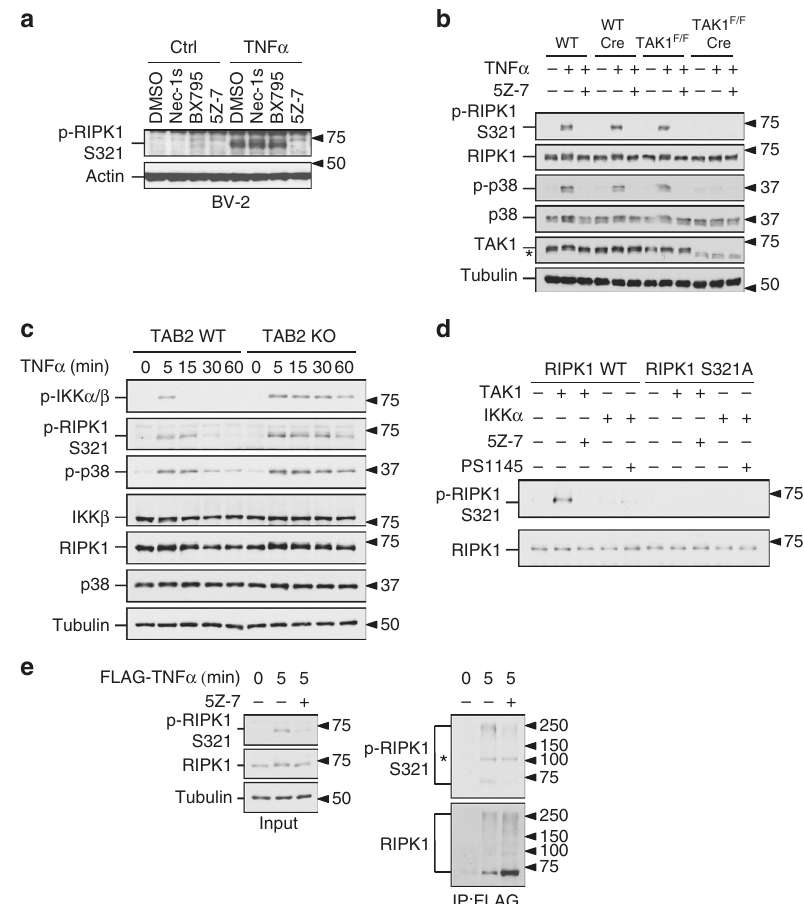
Fig. 2 TAK1 phosphorylates RIPK1 at S321. a TNF α -induced RIPK1 S321 phosphorylation is inhibited by TAK1 inhibitor. BV-2 cells were treated by TNF α (20 ng/ml) together with DMSO, Nec-1s (10 µ M), TBK1 inhibitor, BX795 (1 µ M) and 5Z-7 (0.5 µ M). b TAK1 is required for RIPK1 S321 phosphorylation. WT and TAK1 F/F MEFs with or without Cre expression were treated with TNF α (10 ng/ml) and 5Z-7 (0.5 µ M) for 15 min and examined by indicated antibodies. c Hyperphosphorylation of RIPK1 S321 in TAB2 KO MEF. TAB2 WT and KO MEFs were treated with TNF α (10 ng/ml) and the samples were collected at indicated time-points. d FLAG-RIPK1 WT and S321A were expressed and puri fi ed from 293T cells and incubated with recombinant TAK1-TAB1 or GST-IKK α or their inhibitors, 5Z-7 or PS1145, respectively. The products were analyzed by western blot using indicated antibodies. e RIPK1 S321 phosphorylation